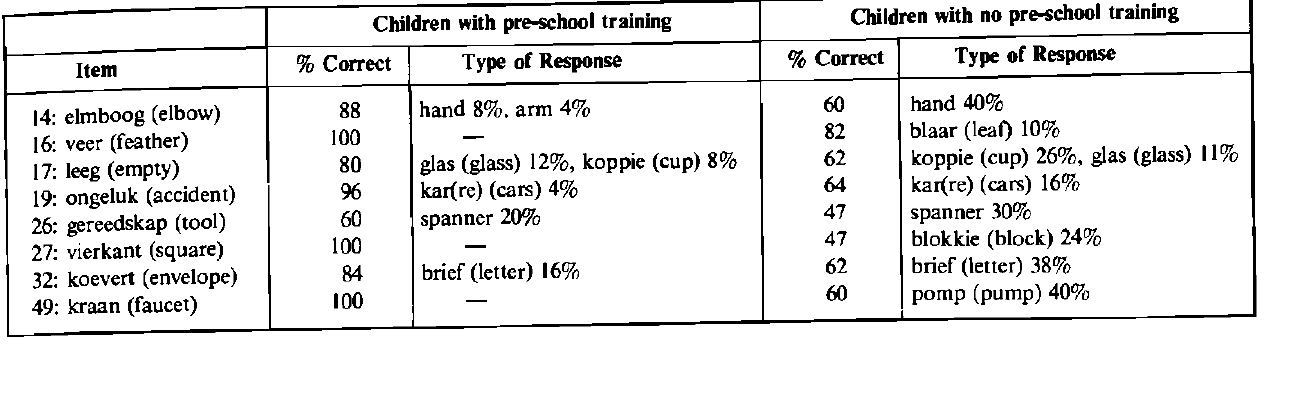
Table 4: Interesting differences in some responses between children with pre-school training and children with no pre-school training.